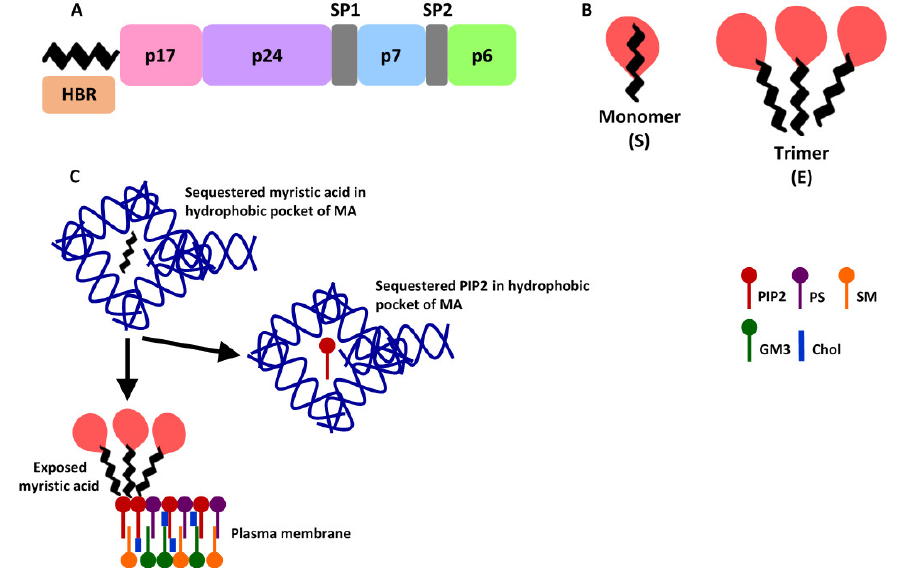
Figure 2. Proposed HIV-1 myristoylation at the molecular level. ( A ) Full length Gag polyprotein with a myristoylated MA at the N-terminal domain. ( B ) Sequestered (S) and Exposed (E) transition states in different MA conformations [37]. ( C ) The sequestered myristic acid switches to exposed upon PIP 2 binding at the plasma membrane. The PIP 2 fatty acid is then sequestered into the vacant hydrophobic pocket (adapted from [38]).